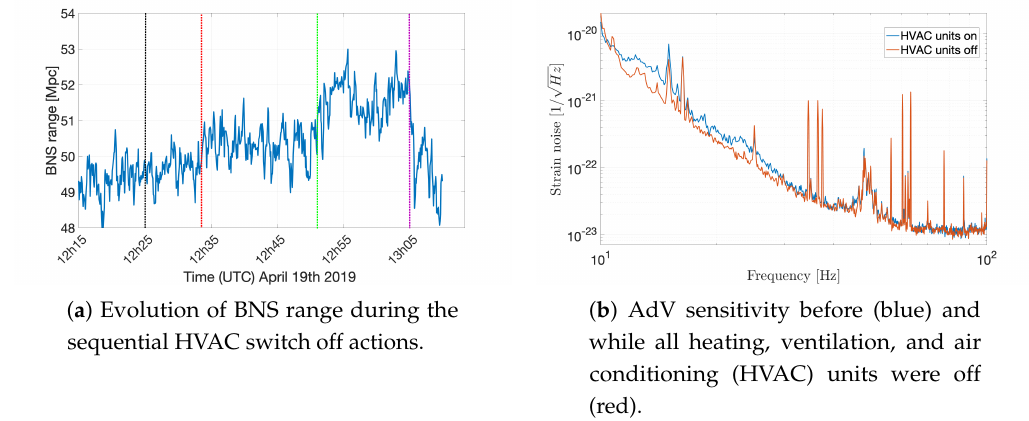
Figure 3. Effect of turning off HVAC devices in binary neutron star range ( a ) and detector sensitivity ( b ). In ( a ), the black and purple dotted lines points out the beginning and ending of the switch off test, the red and green lines indicates the switching off of CEB hall and detection clean room units,